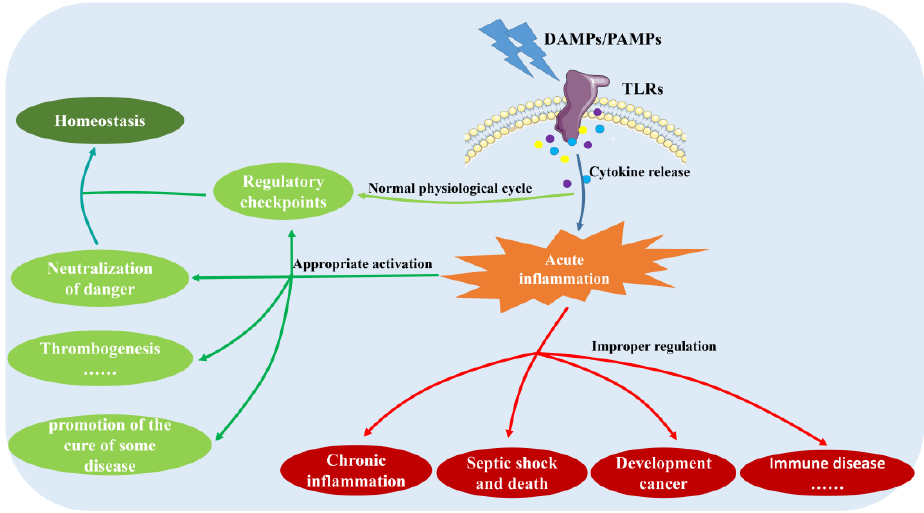
Figure 7. The importance of balancing the TLR2 and TLR4 pathways. TLR activation can restore homeostasis via regulatory checkpoints. We can also use TLR activation to produce inflammatory factors to achieve the therapeutic effect of diseases, but it is worth noting that once over-activated, it will also lead to a variety of diseases. Therefore, it is critical to grasp the extent of TLR activation. DAMPs: Danger-associated molecular patterns; PAMPs: Pathogen-associated molecular patterns; TLRs: Toll-like receptors.